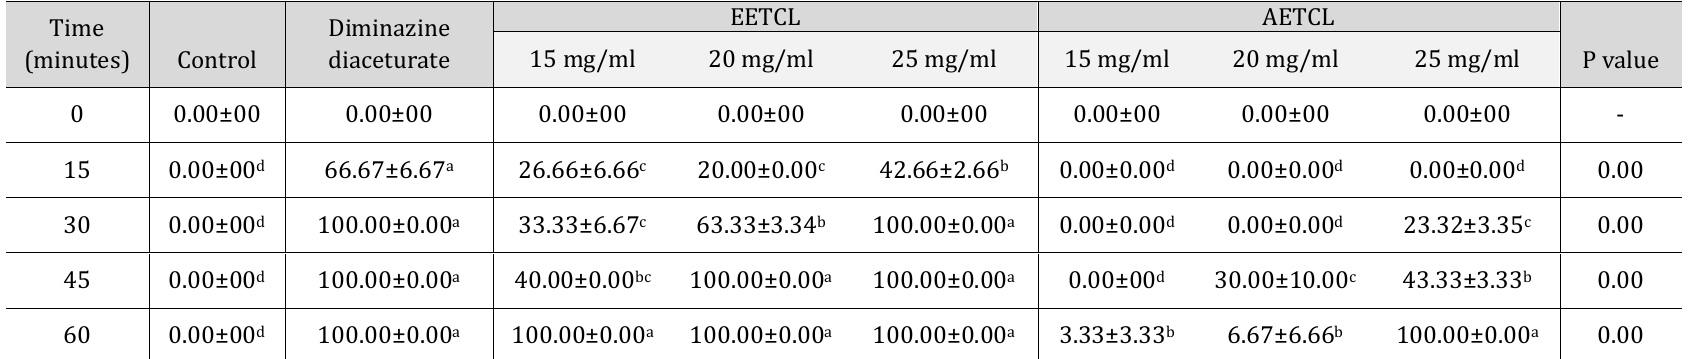
Table 2. In vitro trypanocidal activity (% mortality) of ethanolic and aqueous extracts of Terminalia catappa